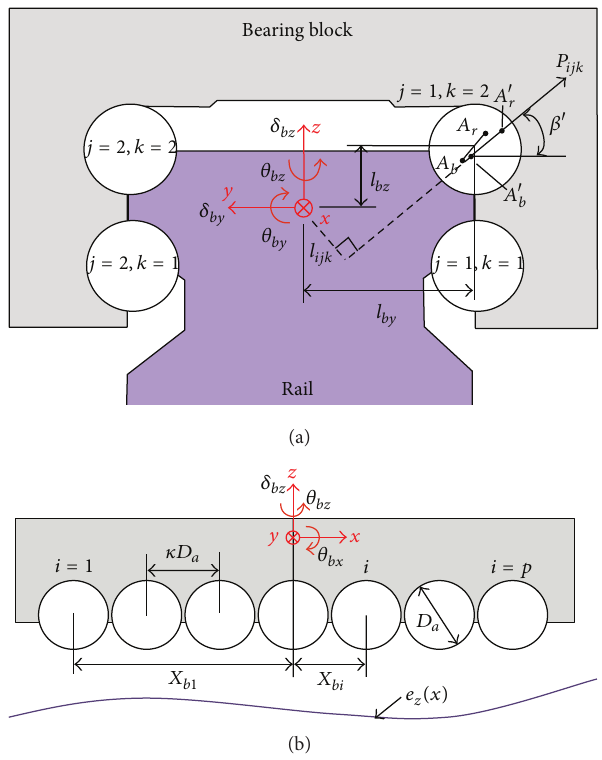
Figure 3: Model of a linear motion bearing block. (a) Front view and (b) side view.